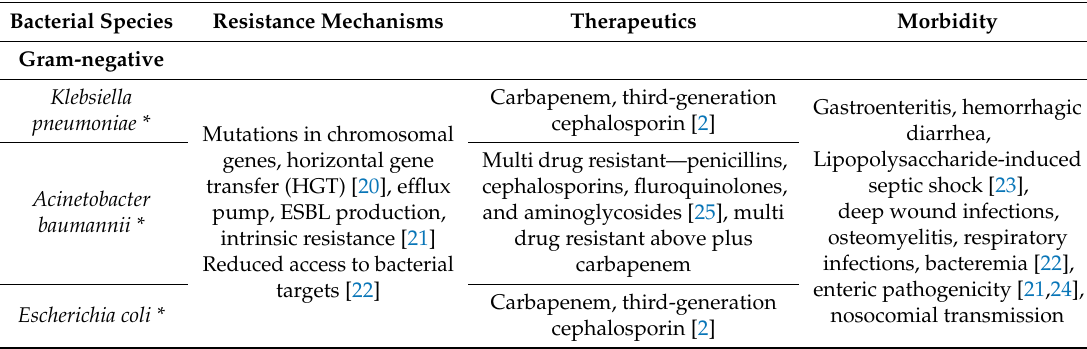
Table 1. Medically important bacterial species, their resistance mechanisms, therapeutics where resistance is evident, and associated